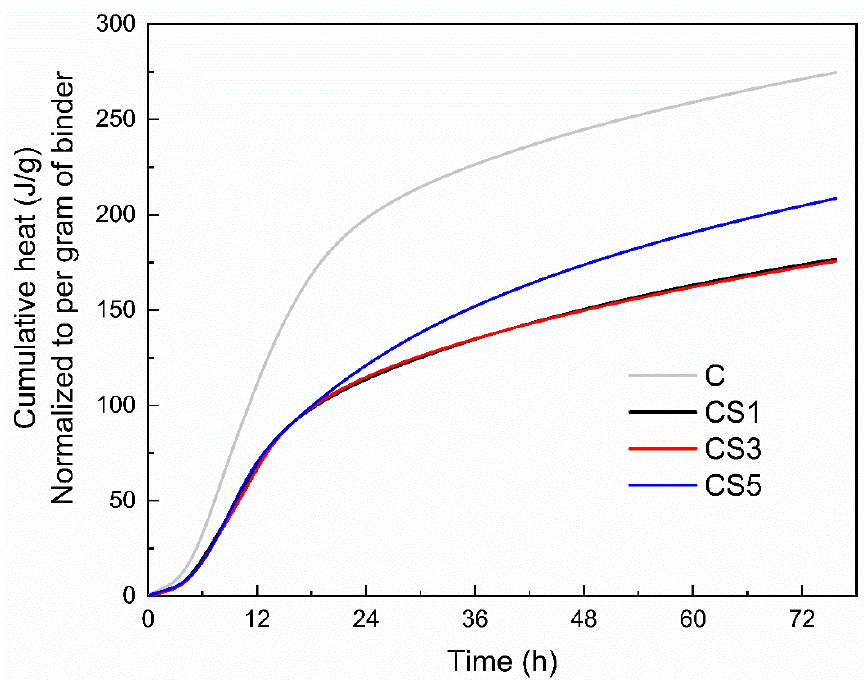
Figure 8. Cumulative heat of slag blended pastes during 72 h of hydration.